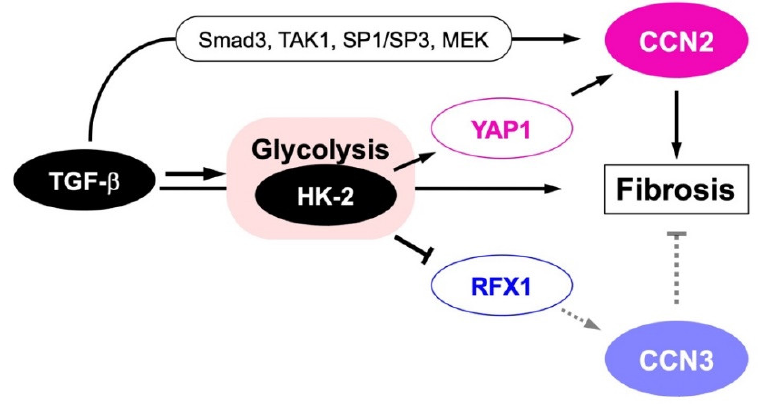
Figure 5. Metabolic yin–yang regulation of CCN2 and CCN3 during fibrotic disorder development. TGF-β signal stimulates CCN2 both directly through specific transcription factors, including Smad3, TGF-β activated kinase 1 (TAK1), specificity protein (SP) 1/SP3 and mitogen-activated protein kinase (MAPK) -extracellular signal regulated kinase (ERK) kinase (MEK), and indirectly through the activation of glycolysis by accumulating hexokinase (HK)-2, which is mediated by yes-associated protein (YAP) 1. Glycolysis activation by TGF-β through HK-2 contrarily represses RFX1 expression, resulting in the repression of antifibrotic CCN3 production. Smad-independent negative regulation of CCN3 by TGF-β observed in nucleus pulposus cells could occur through this metabolic pathway. Finally, CCN2 protein promotes fibrosis in collaboration with TGF-β.